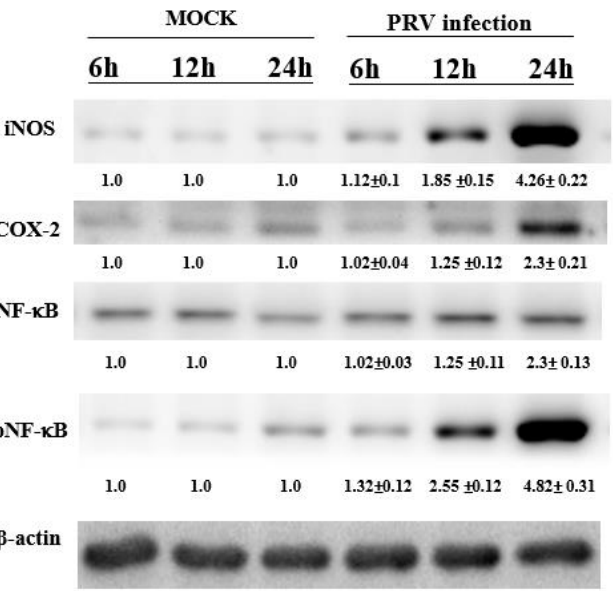
Figure 2. The iNOS, COX-2 and NF- κ B p65 expression in non- or PRV-infected BV-2 cells for 12 – 48 h. Total protein levels in the observed cells were determined through 10% SDS-PAGE and subsequently through Western blotting. The data is normalized with β -actin, and the relative density ratios shown here are the PRV-infected and non-infected groups at the same time point. Data are presented as the mean ± SD ( n = 3).